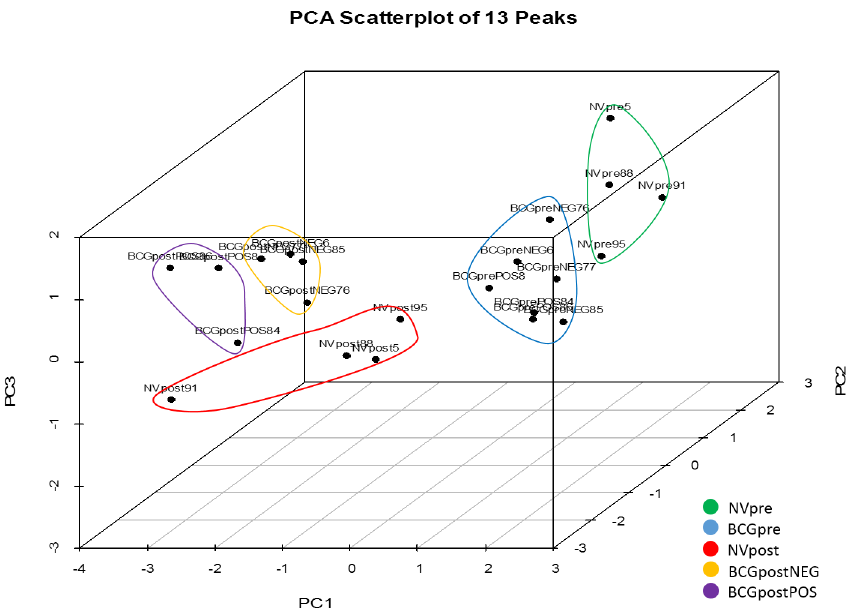
Fig 3. Three dimensional principal components analysis scatterplot of 13 peaks. All BCG-vaccinated individuals are located within one cluster prior to challengeindicating that there is little difference present amongvaccinatedindividuals at this time-point. NVpre individualsare locatedin a cluster distinctlyseparate from BCGpre individuals. Pre- and post-challenge sample groups are separate, indicatingthat differences exist betweenpre-andpost-challenge individuals.Post-challenge, two BCG sample groupsare present, and are distinctly separatefrom the NVpost sample group. Individualswithin treatment groups cluster in close association indicatingsimilarity amongindividualswith respect to vaccinationand/or persistenceof virulent M . bovis .